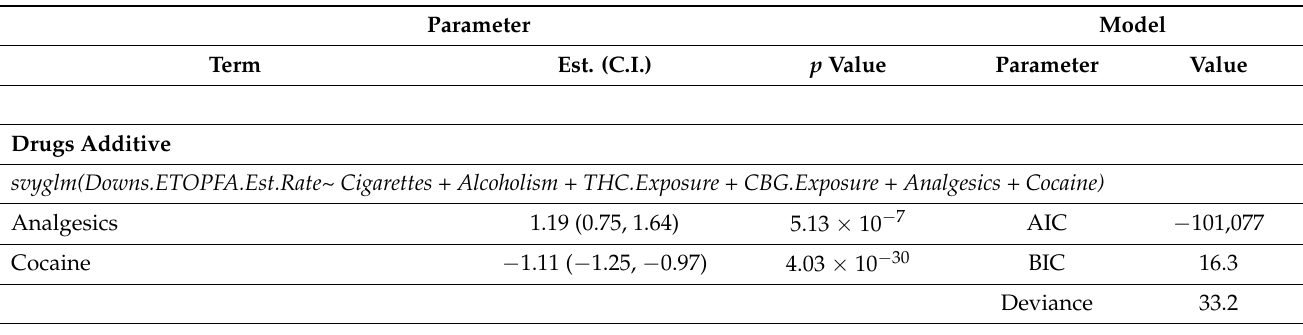
Table 4. Robust Regression Results (from R Survey